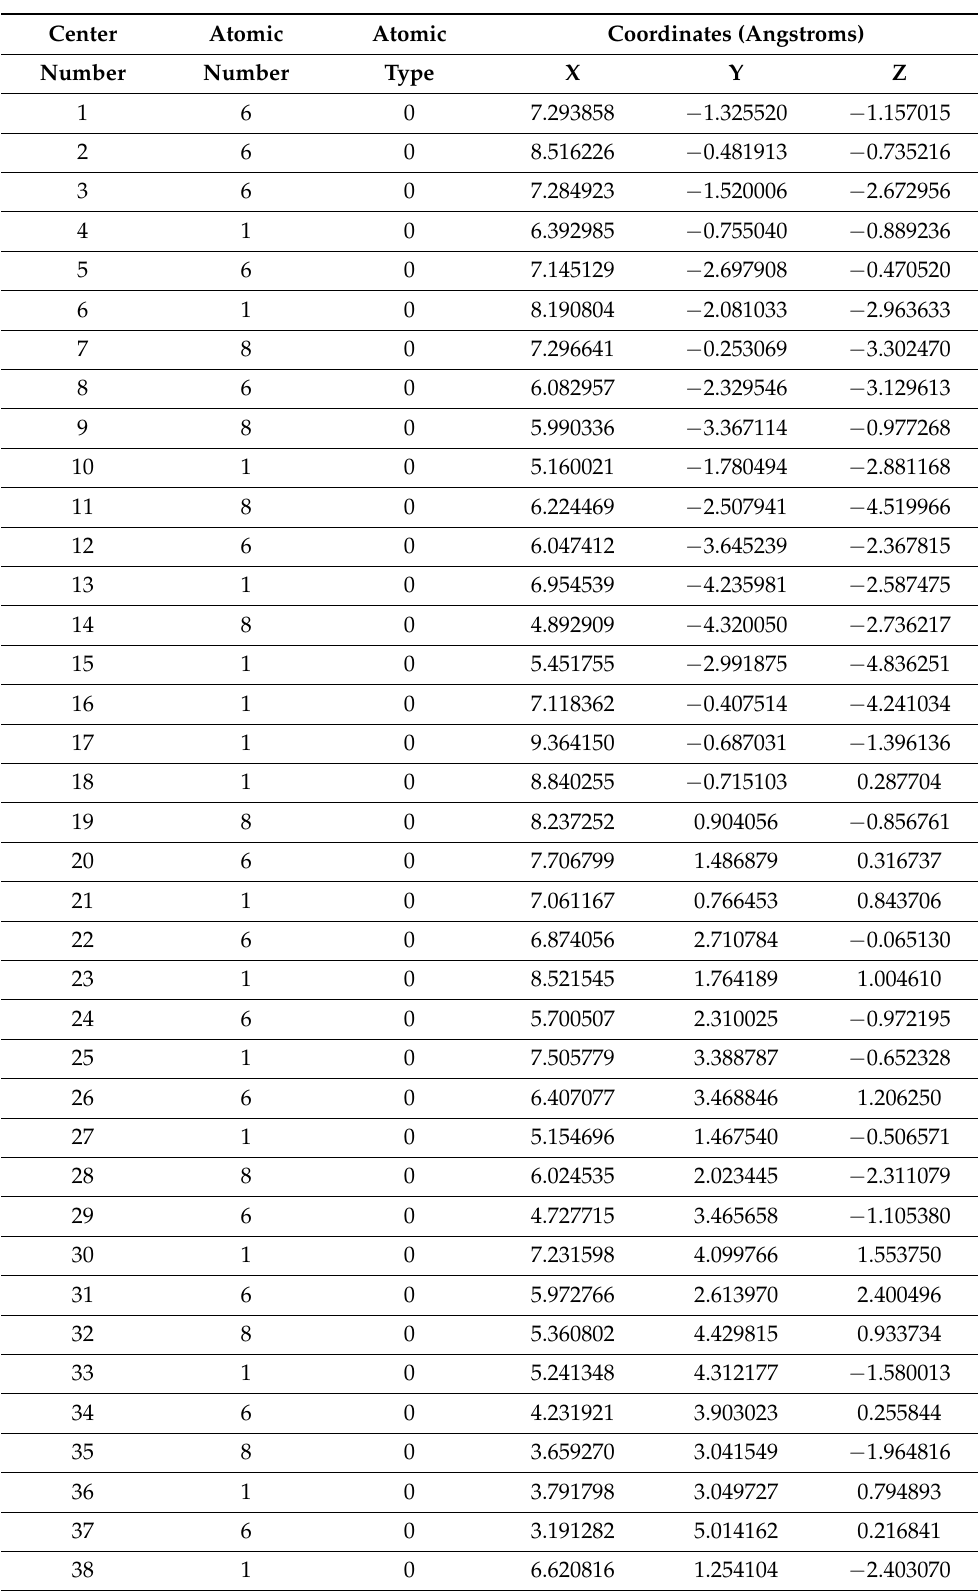
Table A2. Complex II. MgI 3 LiII 2 in the dextrin